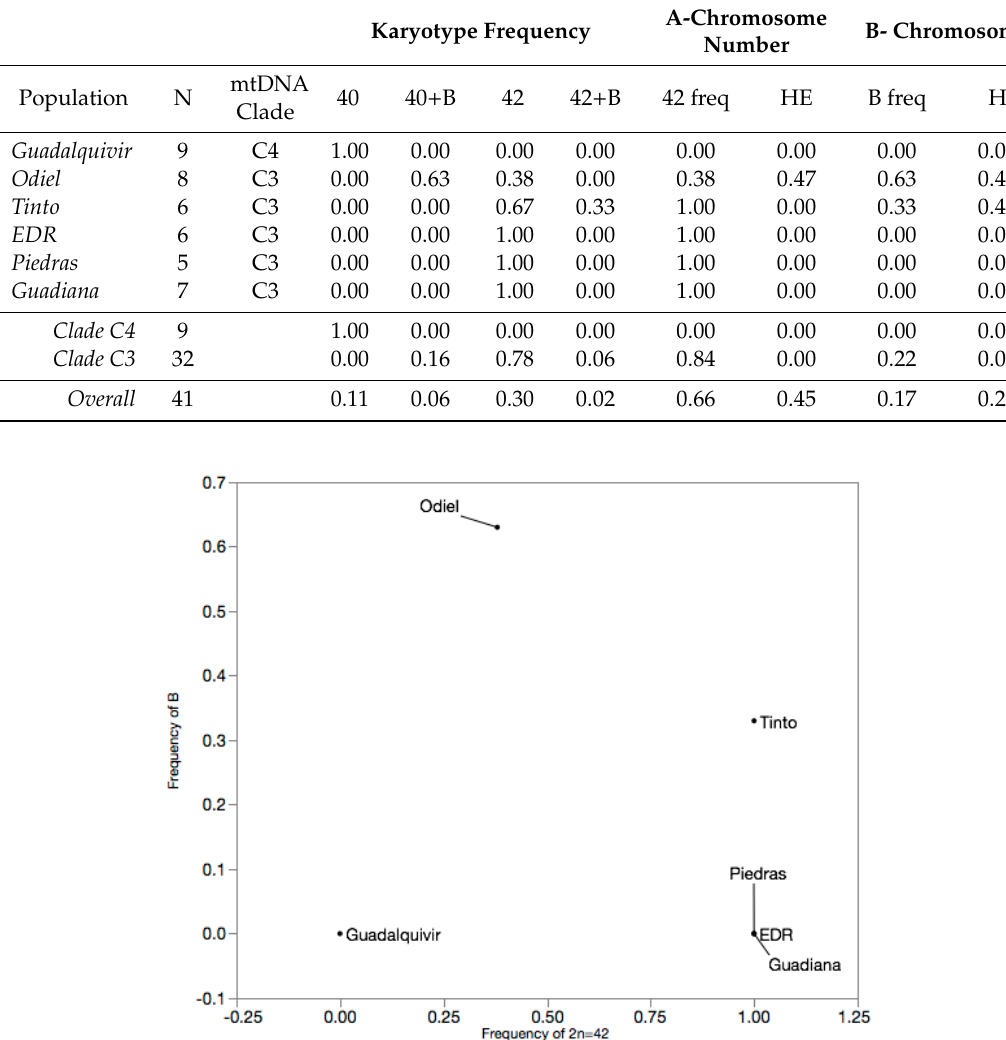
Table 2. Distribution of karyotypes across populations and karyotypic diversity. The frequency distribution of karyotypes for the composite karyotype and the frequency and diversity statistics for the A-chromosome number and B-chromosome presence are shown for each population, mtDNA lineage and for the pool of samples from the Gulf of Cádiz. Diversity is measured as expected heterozygosity and haplotype diversity for A-chromosome number and B-chromosome, respectively.